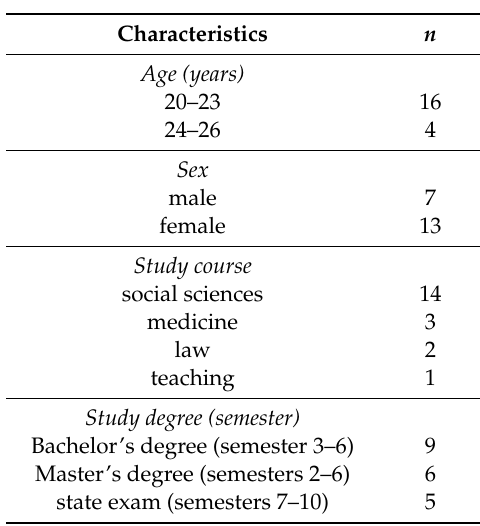
Table 1. Characteristics of students participating in the qualitative part of the Nutrition and Physical Activity in Adolescence (NuPhA) -Study ( n =